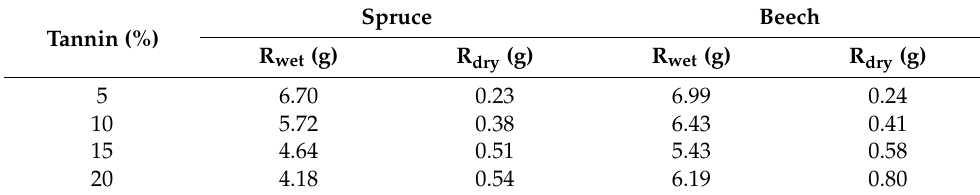
Table 1. Solution and tannin uptake for different concentrations of tannin–water solution for spruce ( Picea abies ) and beech ( Fagus sylvatica ). Spruce Beech Tannin (%) R wet (g) R dry (g) R wet (g) R dry